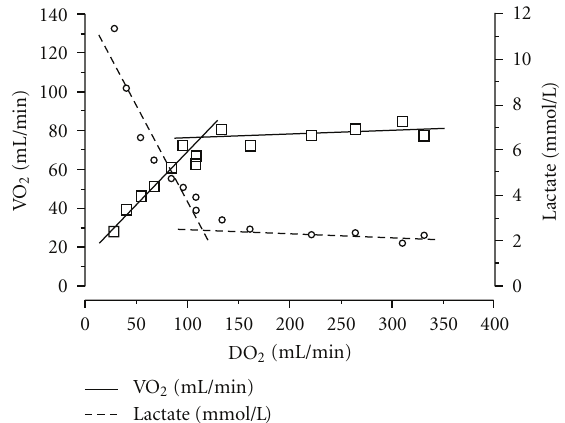
Figure 1: Evolution of oxygen consumption when oxygen delivery decreases. From Vincent and De Backer [5] with permission. Note the presence of a DO 2 threshold located at approximately 100 mL/min. Below this value, oxygen consumption begins to fall and lactate concentration increases, indicating a switch from aer- obic to anaerobic